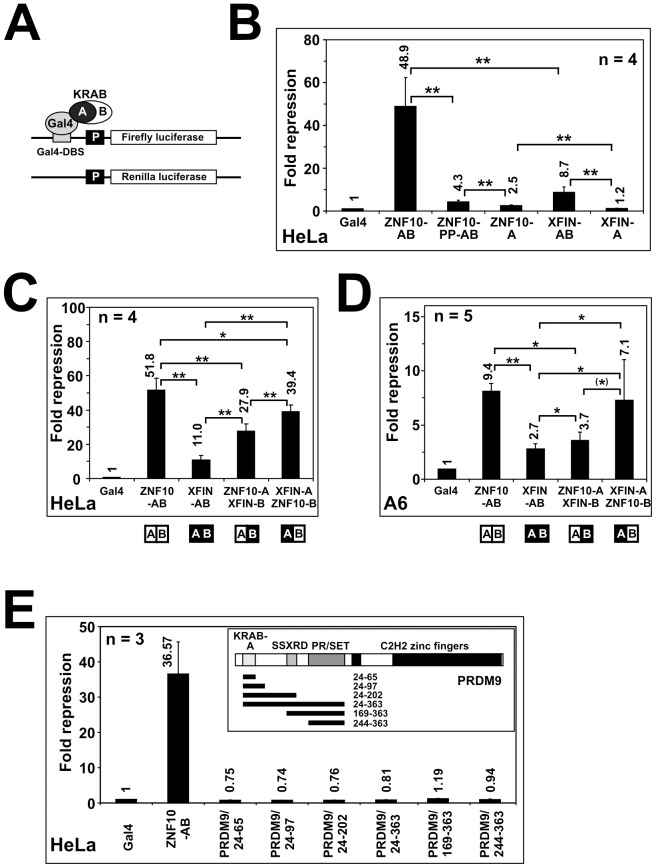
Evaluation of the transcriptional repression potential of different KRAB domains.Heterologous luciferase reporter assays using fusions between the indicated KRAB domains and the Gal4-DNA-binding domain (Gal4). Results of 3–5 independend experiments (n = 3–5, see charts). Asterisks denote statistical significance in a two-tailed paired T-test (one asterisk in brackets means p<0.055; one asterisk p<0.05, two asterisks p<0.01 and three asterisk p<0.001); A: Illustration of assay; only the firefly luciferase reporter carries upstream Gal4 DNA-binding sites (Gal4-DBS) while the Renilla luciferase does not and is used for normalization. B: Assay in human HeLa cells, comparing Gal4 as baseline (set to 1) with its fusions to the indicated KRAB domains/subdomains. C: KRAB-B domain swapping experiment in human HeLa cells, switching the ZNF10-B domain to XFIN-A and vice versa. D: Same experiment as C, but done in Xenopus laevis A6 cells. E: Testing of various N-terminal parts of PRDM9 in human HeLa cells, numbers designate amino acid positions in the full-length protein. PRDM9 domain abbreviations: SSXRD = SSX repression domain motif (PFAM PF09514; [78]); PR/SET = derivative of SET doman , (Drosophila Su(var)3–9, Enhancer-of-zeste and Trithorax; PFAM PF00856 [79].